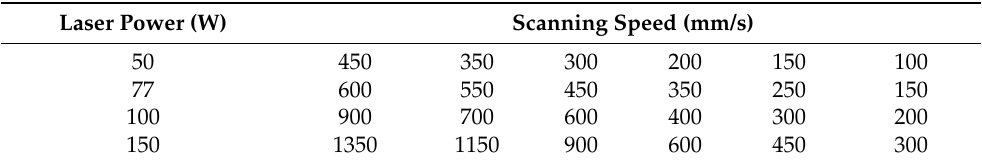
Table 2. The combinations of parameters used in the